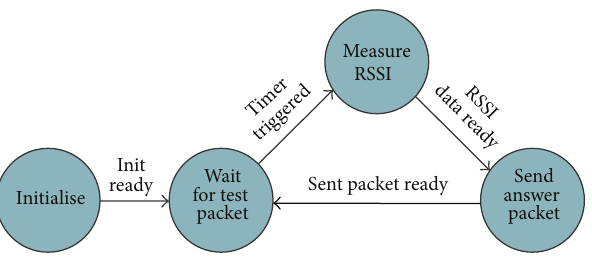
Figure 6: Workflow diagram of the RSSI sensing